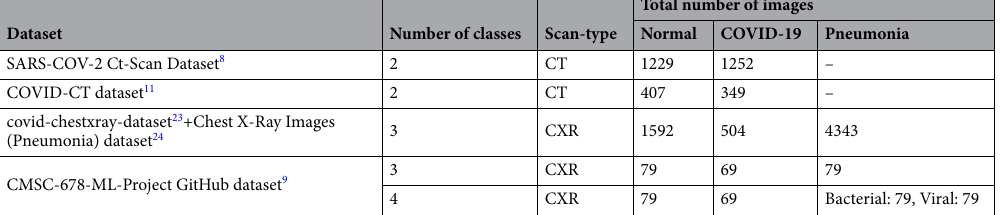
Table 5. Statistical description of all the datasets used for experimentation.